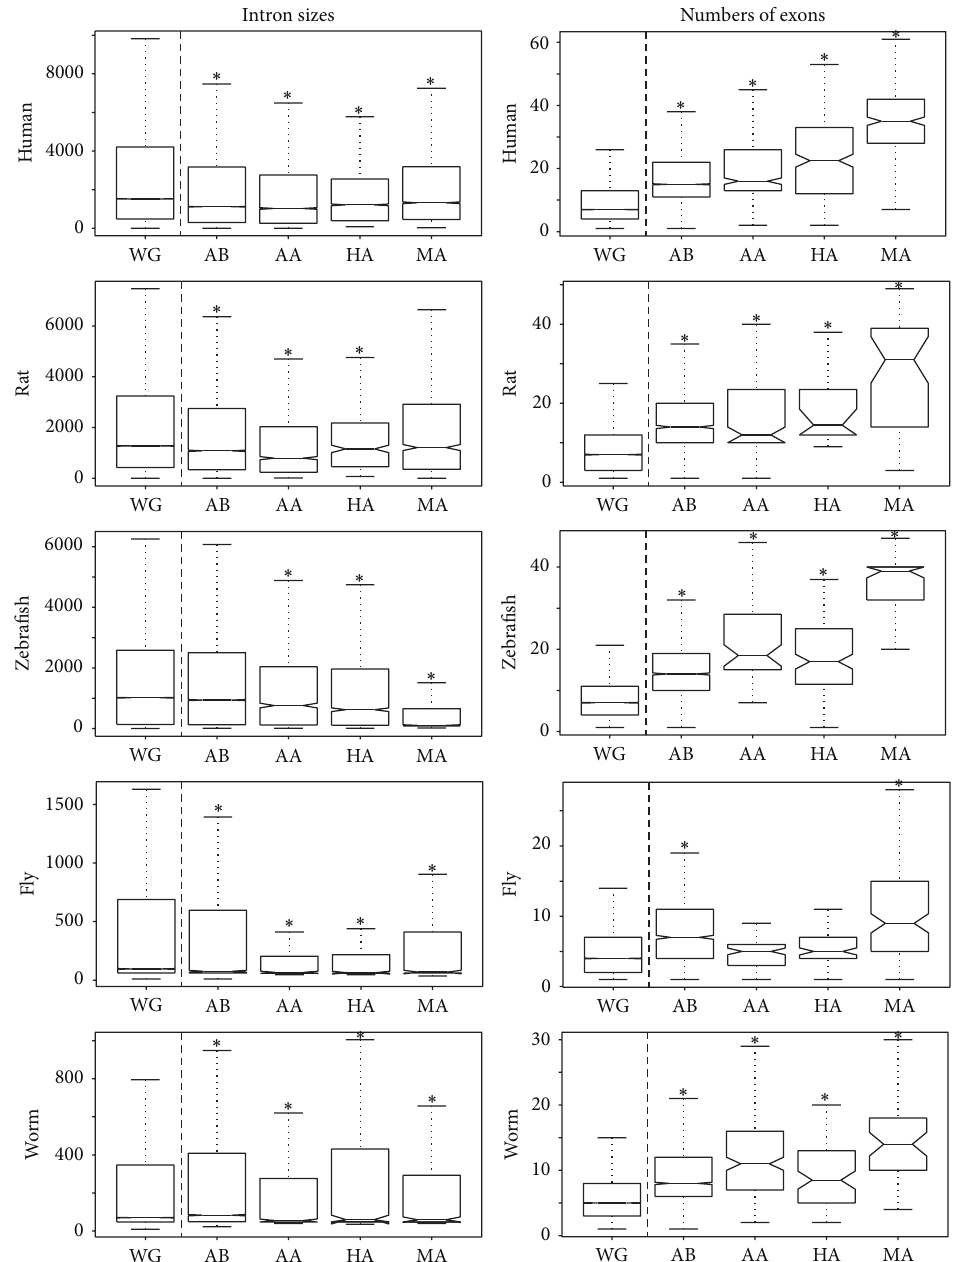
Figure 3: Boxplots of genomic characteristics for several ontological categories in comparison to the entire genome. Boxplots of intron sizes and numbers of exons are shown for the whole genome (WG), ATP binding (AB), ATPase activity (AA), helicase activity (HA), and motor activity (MA) across the 5 species of interest. Values that differ significantly from the whole genome are indicated with an